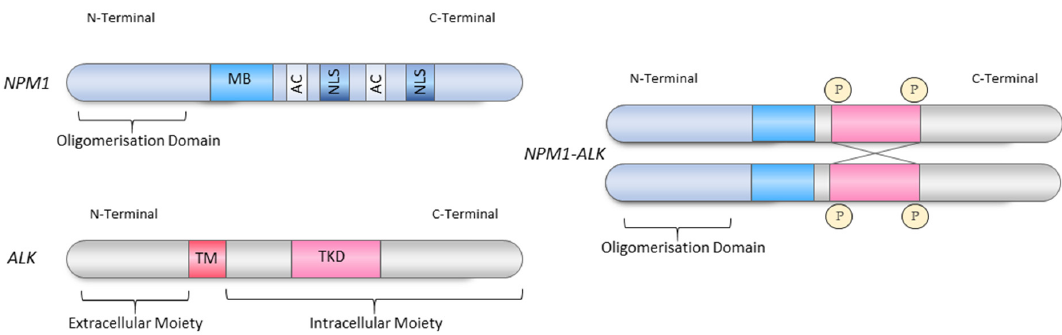
Figure 1. The Nucleophosmin 1 (NPM1)-ALK fusion protein resulting from the t(2;5)(p23;q25) . Fusion of the NPM1 gene on chromosome 5 to the ALK gene on chromosome 2 results in the expression of NPM1-ALK, a constitutively activate tyrosine kinase. NPM1 encodes an oligomerisation domain (residues 1–117), a metal binding domain (MB; residues 104–115), two acidic amino acid clusters (AC: D and E amino acid rich domains which function as acceptor regions for nucleolar targeting signals; residues 120–132 and 161–188) and two nuclear localisation signals (NLS; residues 152–157 and 191–197). ALK encodes a Meprin/A5/protein tyrosine phosphatase domain (not shown), a ligand-binding site (residues 391–401) in the extracellular domain, a lipophilic transmembrane region (TM) and an intracellular domain that contains the tyrosine-kinase catalytic domain (TKD).